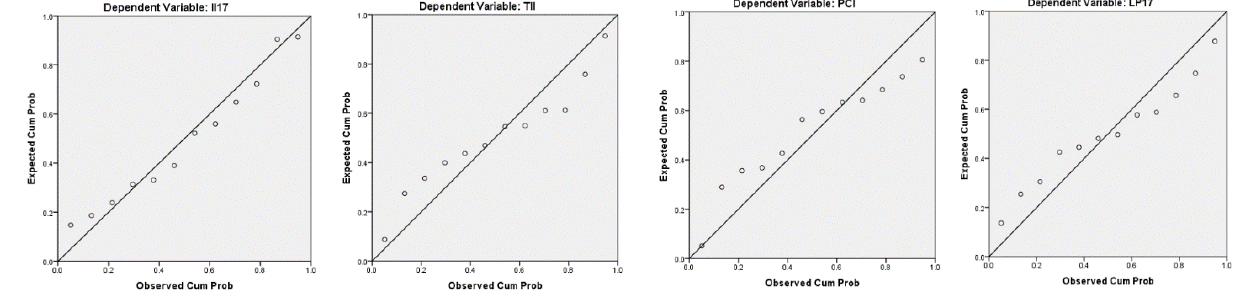
Figure 11. Normal P – P plot regression standardized residual. Figure 11. Normal P–P plot regression standardized residual.